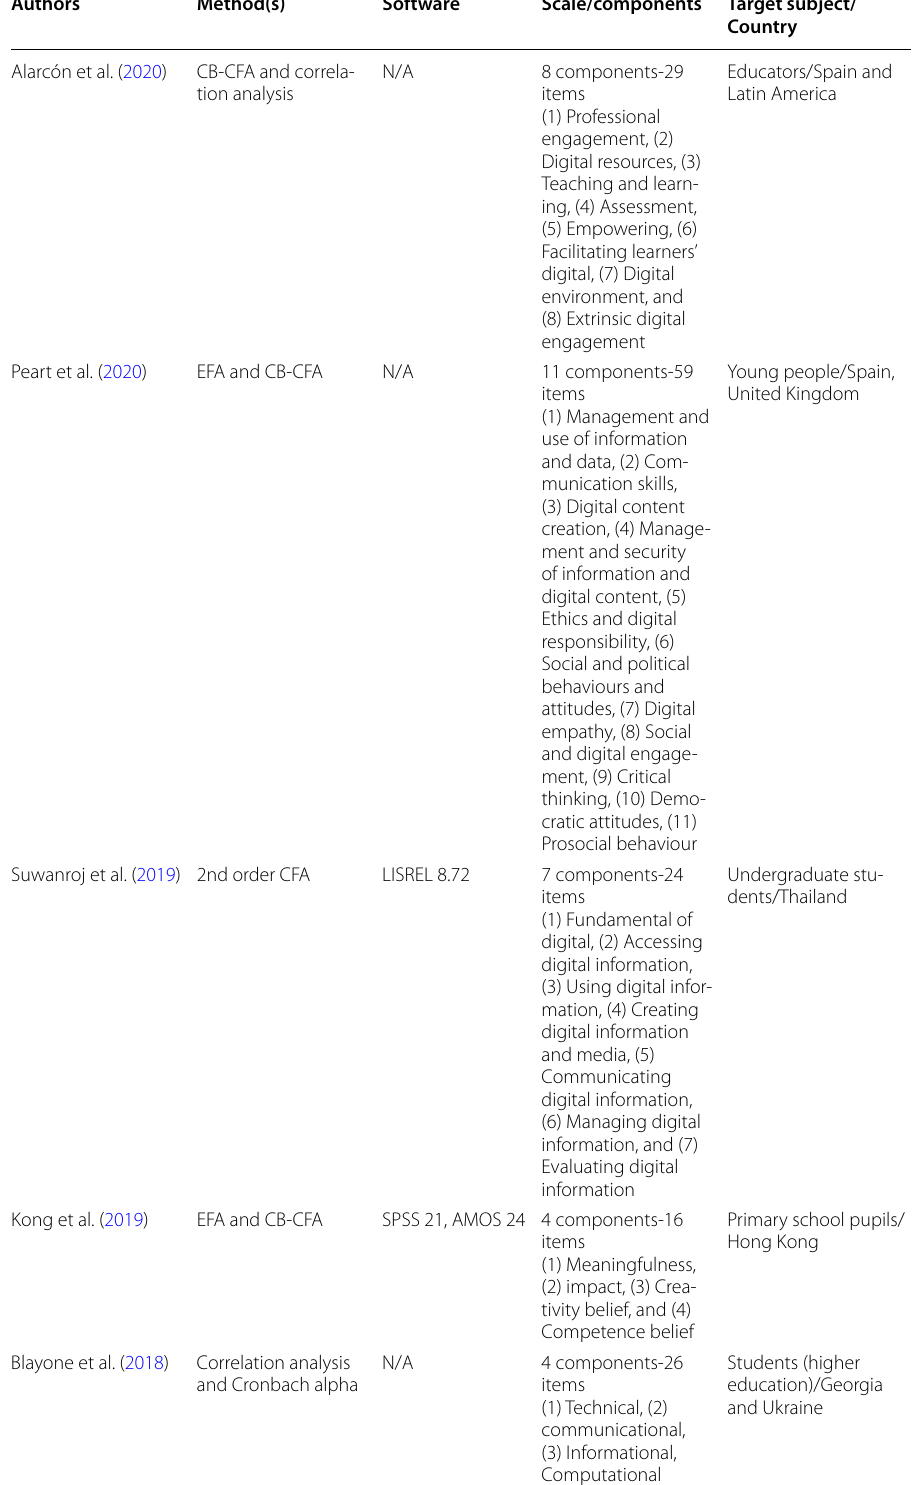
Table 1 Quantitative studies on digital skills scale development/validation across different